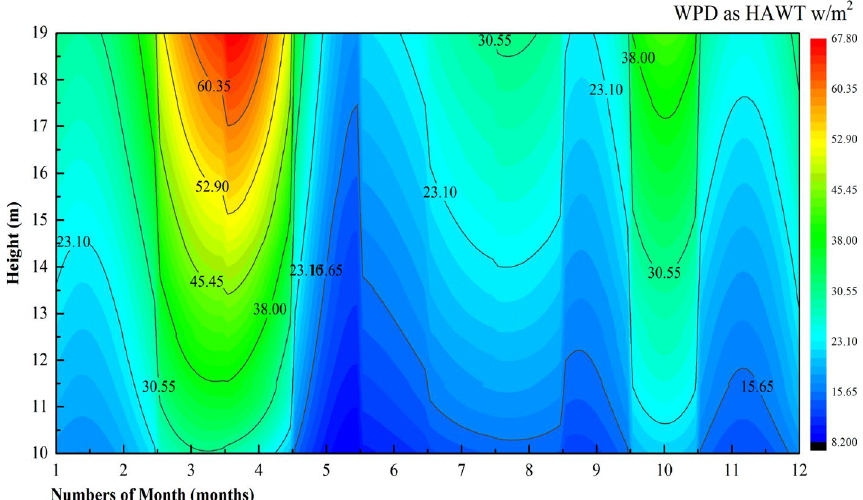
Figure 19. Wind energy density (HAWT) per month at 10–19 m.